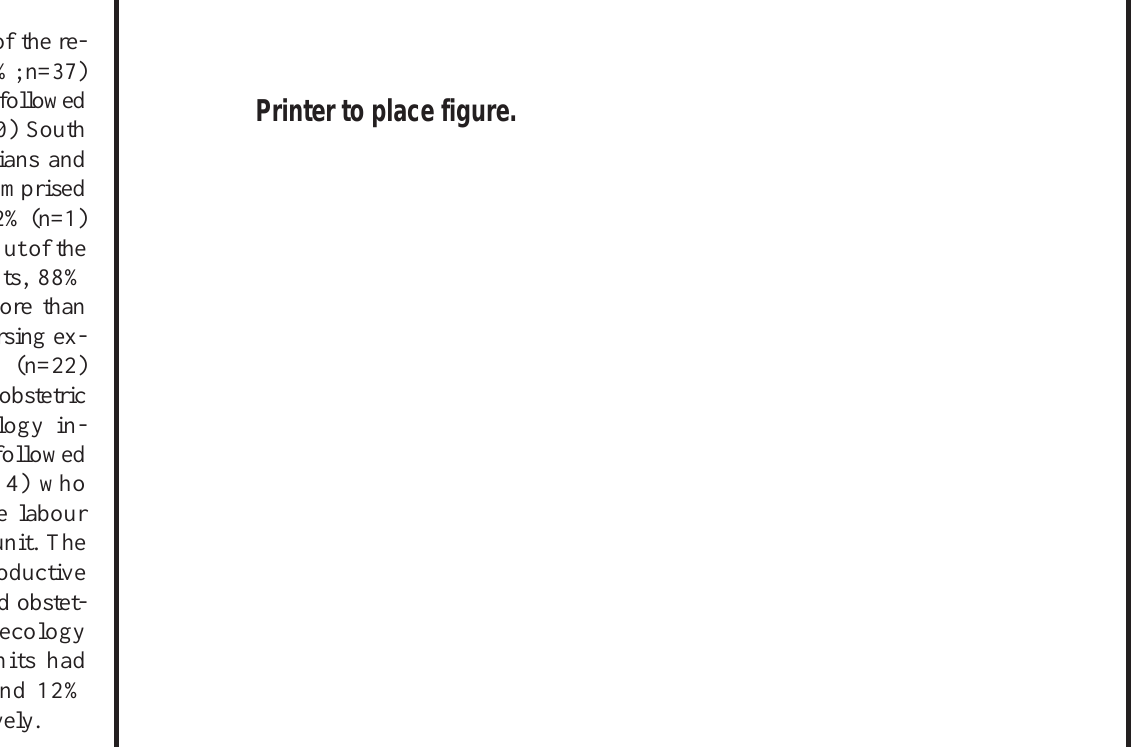
Figure 1: Responses to the geographic, cultural, religious affiliation and occupation